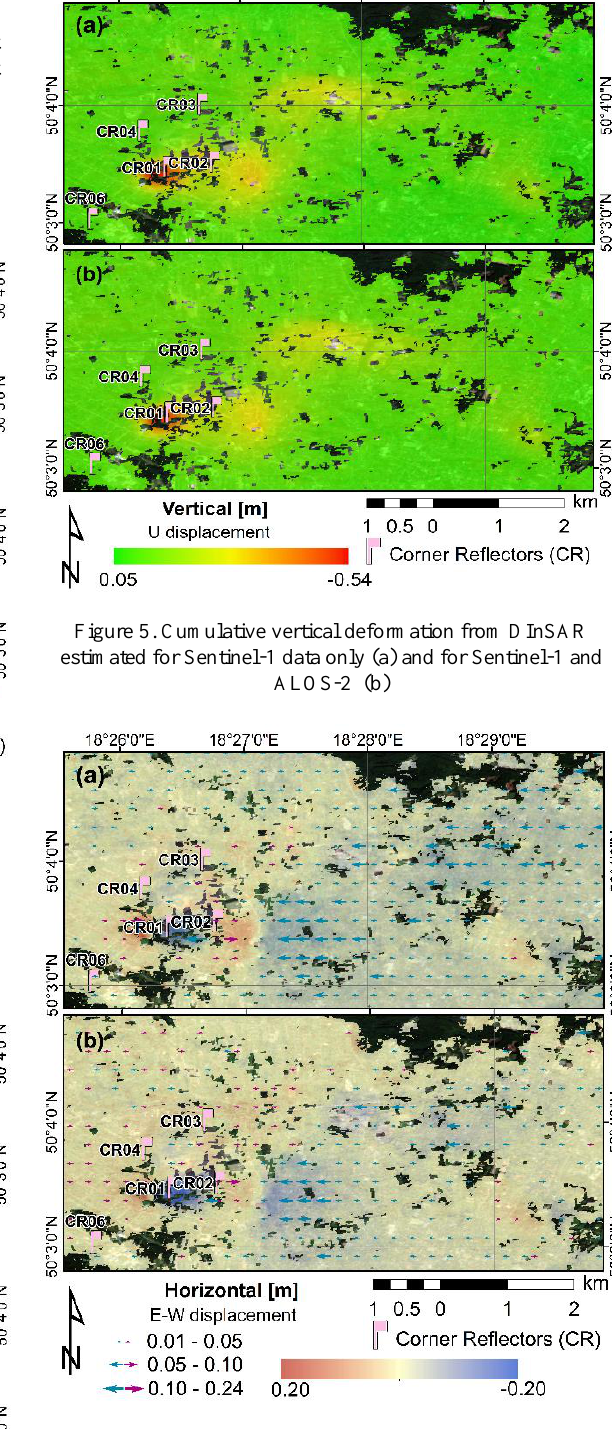
Figure 6. Cumulative horizontal deformation from DInSAR estimated for Sentinel-1 data only (a) and for Sentinel-1